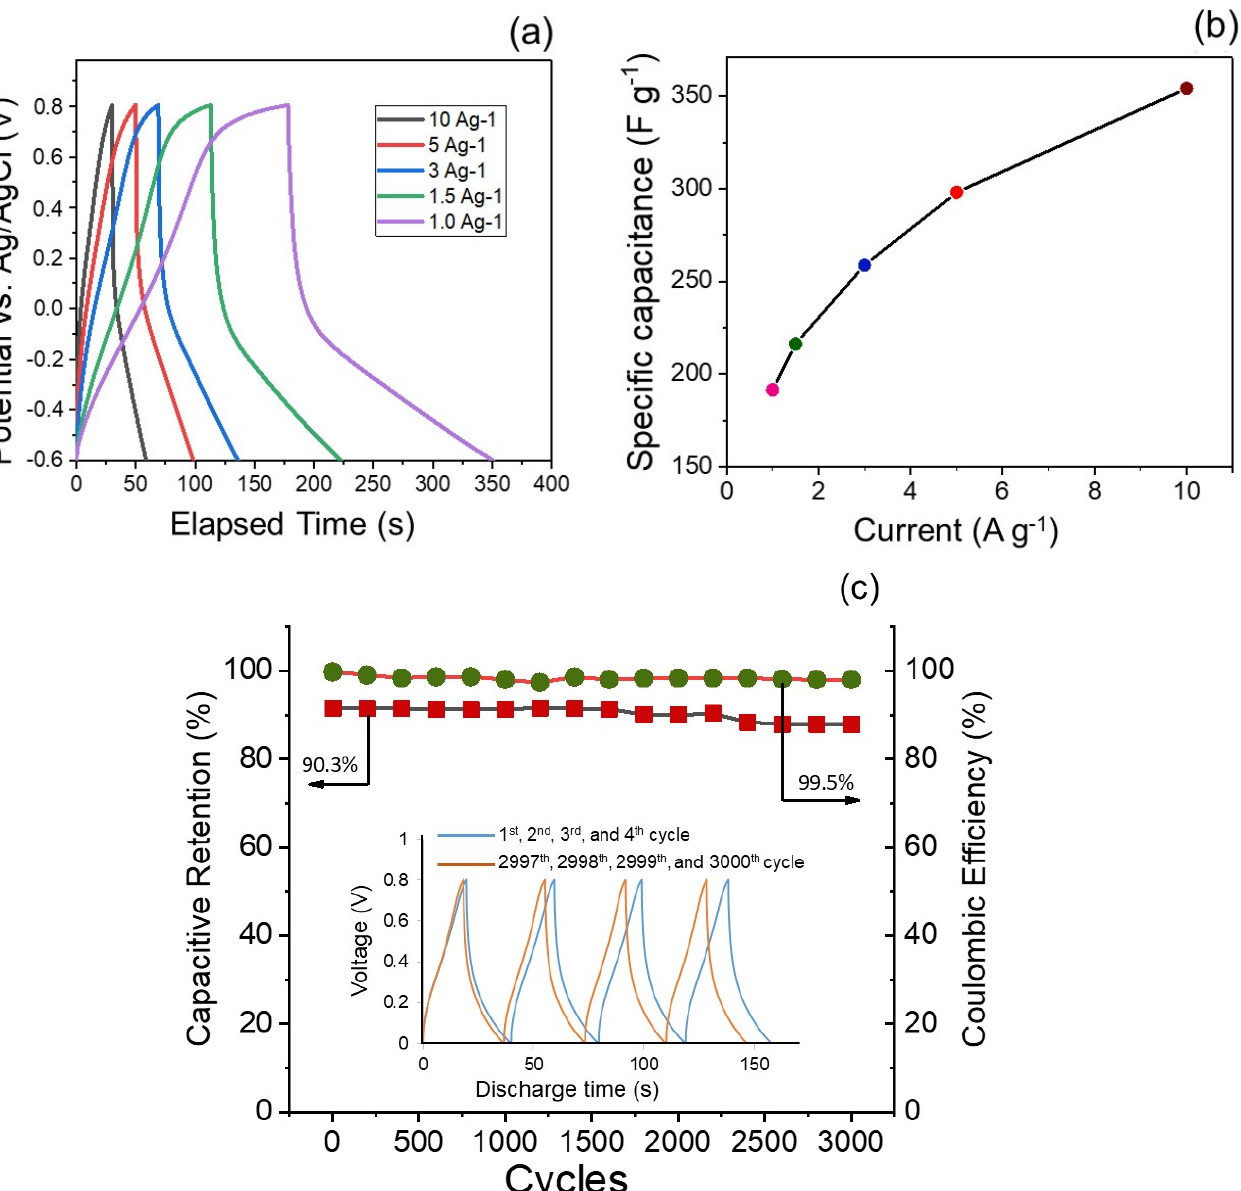
Figure 4. Electrochemical performance of the semi-polycrystalline polyaniline in aqueous electrolyte: ( a ) GCD curves obtained at different current densities ranging from 2–12 A g − 1 ; ( b ) evolution of specific capacitance with respect to the different current densities; ( c ) long-term cycling stability and coulombic efficiency up to 3000 continuous charge–discharge cycles at a current density of 12 A g − 1 .